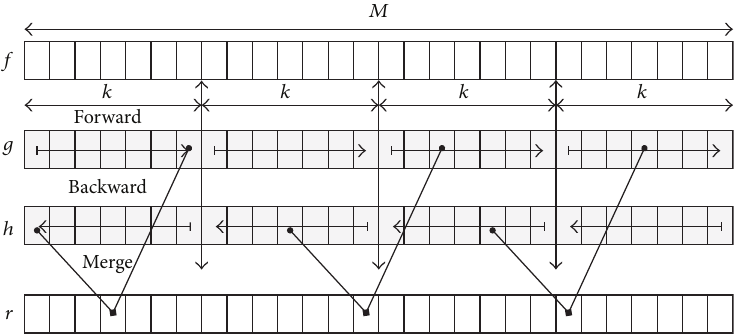
Figure 1: A simplified view of the main steps, forward, backward, and merge, of the HGW algorithm for a linear kernel of size 𝑘 over an input sequence 𝑓 of size 𝑀